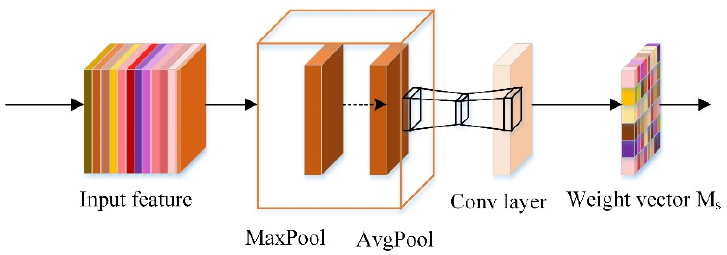
Figure 9. The structure of spatial attention module.